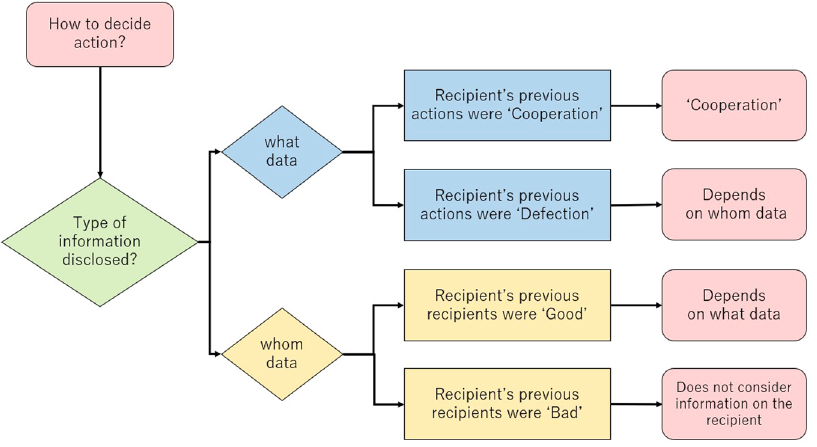
Figure 3. Flowchart of decision-making using information about recipients. This conceptual flowchart represents a summary of the factors determining cooperative behavior in Models 4 to 7 in Table 1, where the labels ‘G’ and ‘B’ correspond to ‘3 or more’ and ‘2 or less’ C actions, respectively, in the previous five rounds. When a subject first receives what data about their recipient, they obtain either ‘C’ or ‘D’ as the recipient’s action. If ‘C’, the subject decides to cooperate with the recipient regardless of the content of the whom data. If ‘D’, the subject then receives the related whom data, in which they obtain either ‘G’ or ‘B’ regarding